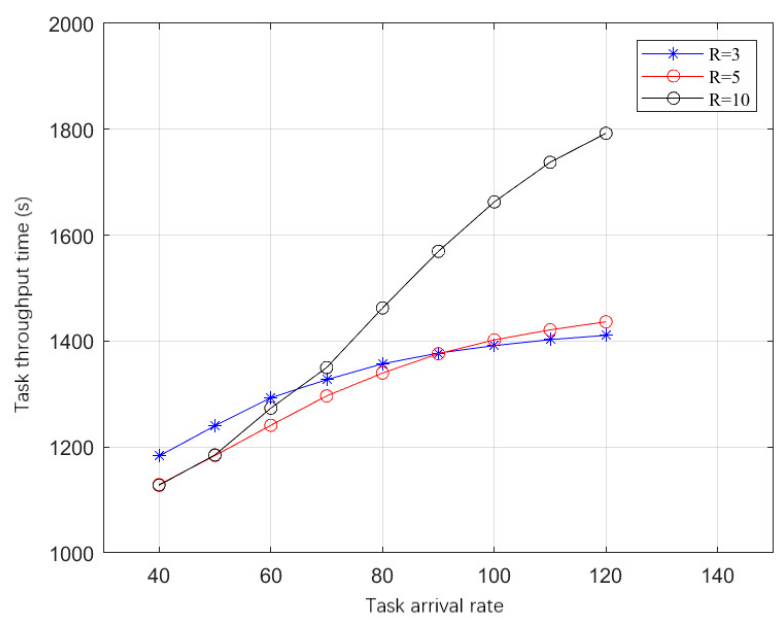
Figure 9. The curve of the task throughput time with the task arrival rate.